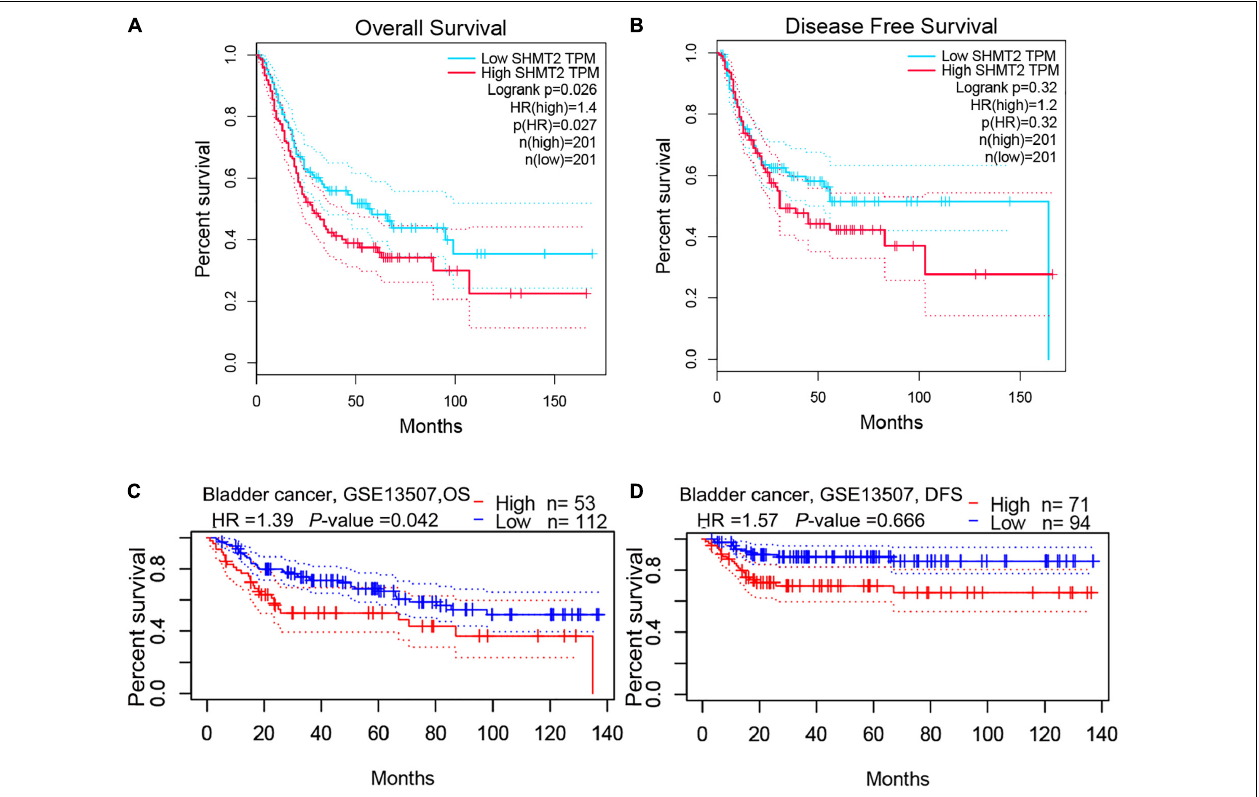
FIGURE 3 | High SHMT2 expression predicts poorer prognosis in BLCA. Based on GEPIA database, we found SHMT2 overexpression was correlated with poorer OS ( P = 0.026) (A), but showed no correlation with DFS ( P = 0.32) (B). As expect, a high SHMT2 expression was significantly associated with a poorer OS ( P = 0.042) of BLCA patients (C) , but was not correlated with the DFS ( P = 0.066) based on GSE13507 in PrognoScan database (D) . overall survival, OS; disease-free survival, DFS, P < 0.05 was recognized as statistically